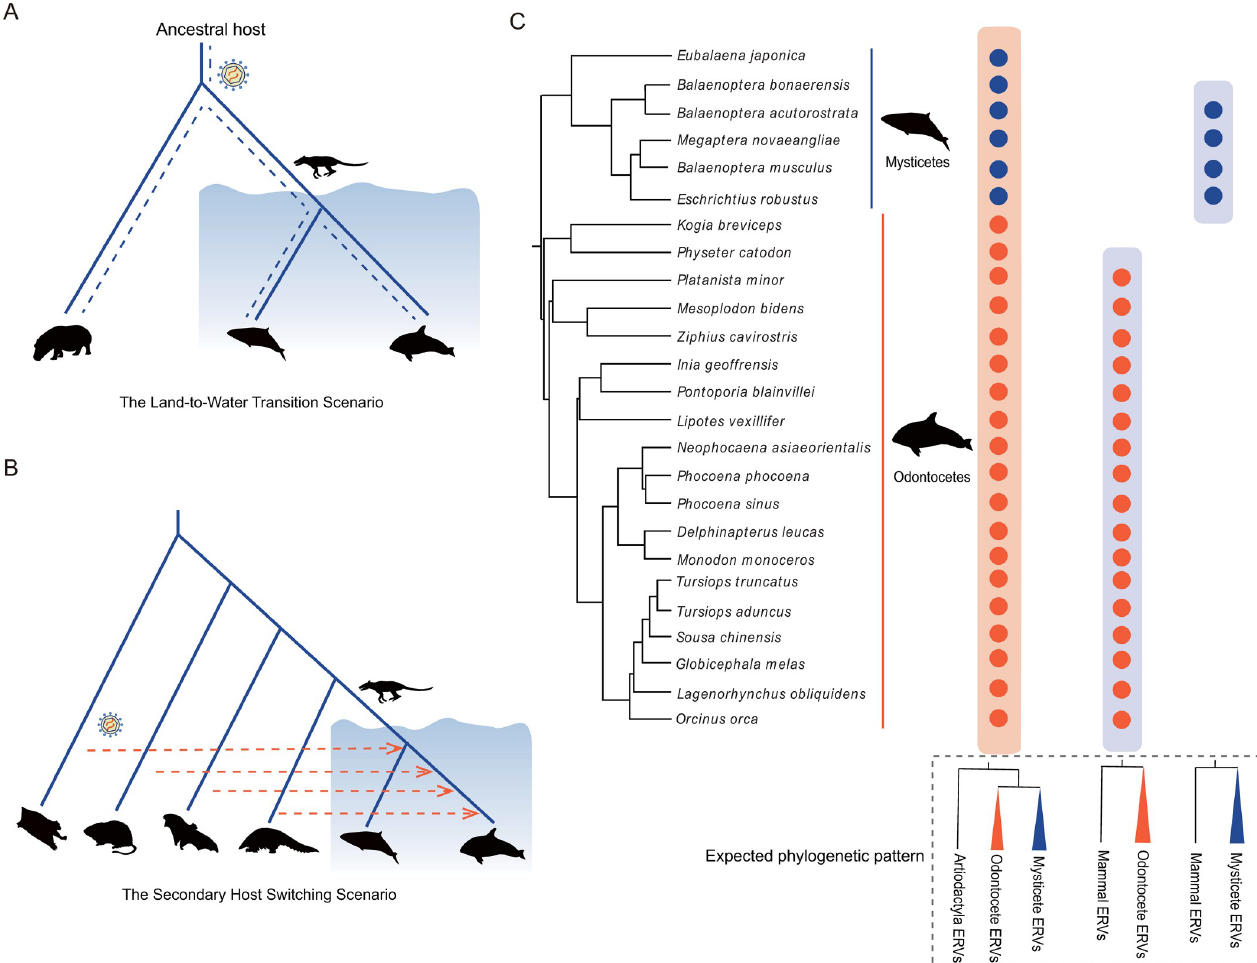
Fig 1. Scenarios of retrovirus evolution in cetaceans. ( A ) The land-to-water transition (LTW) scenario. A retrovirus infected and became integrated in the ancestor of cetaceans before or during the conquest of aquatic environment and transitioned into water with their ancient cetacean hosts. ( B ) The secondary host switching (SHS) scenario. Retroviruses infected and became endogenized in cetaceans through cross-species transmission from diverse sources after cetaceans became fully aquatic. ( C ) The distribution and expected phylogenetic pattern of cetacean ERVs under two scenarios. Under the LTW scenario, the ERV should be identified in the genomes of nearly all the cetaceans. Most of the cetacean ERVs are expected to be closely related to H . amphibious ERVs, while others are most closely related to artiodactyla (except the H . amphibious ). Under the SHS scenario, the ERV should only be identified in a sub-lineage of cetaceans. The ERV is not expected to be closely related to ERVs from any certain vertebrate species. The phylogenetic relationships of cetaceans are based on TimeTree [64] and literatures [65, 66]. Illustrations of mysticetes, odontocetes, and Pakicetus courtesy by Chris Huh, Chris Huh, and Conty, respectively.